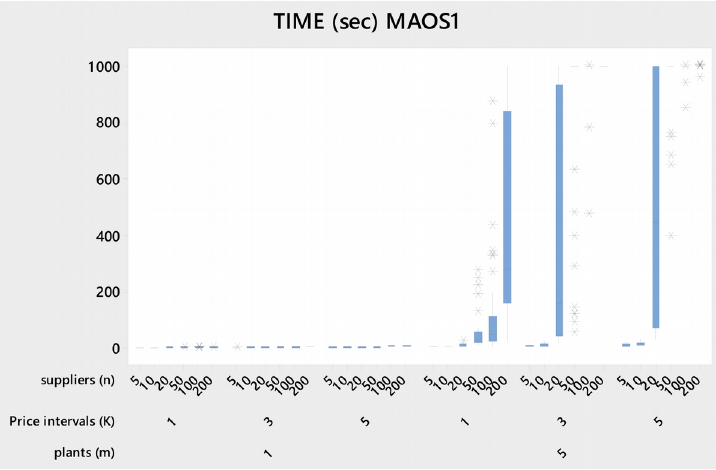
Figure 2. Solving time of